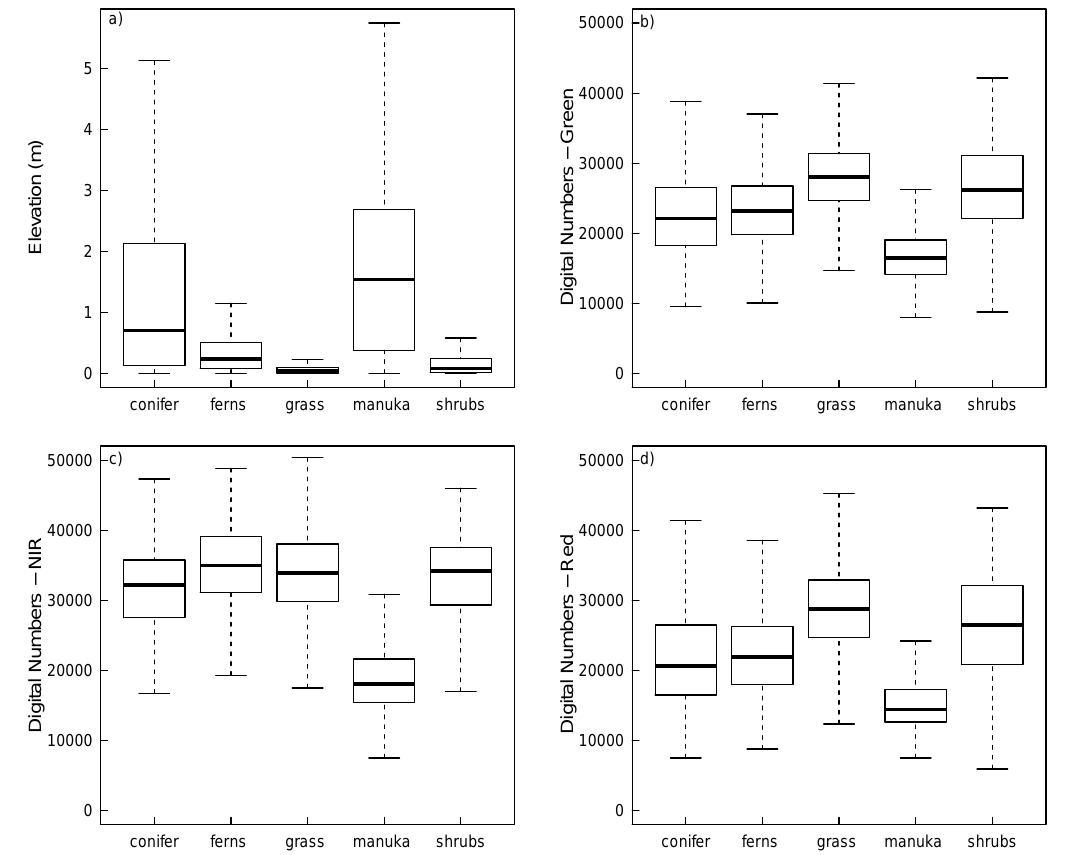
Figure 2. Box and whisker plots showing the spectral and structural properties of invasive conifers (conifer) and the other major vegetation types in the study area derived from the coloured ALS point cloud. Panels show ( a ) return elevation; ( b ) spectral properties in the green band; ( c ) spectral properties in the near-infrared band; ( d ) spectral properties in the red